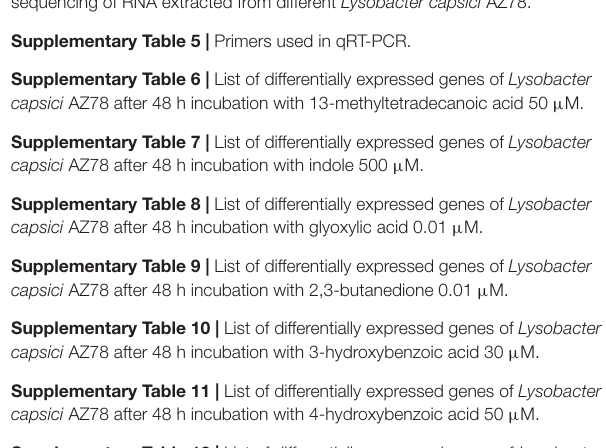
Supplementary Table 5 | Primers used in